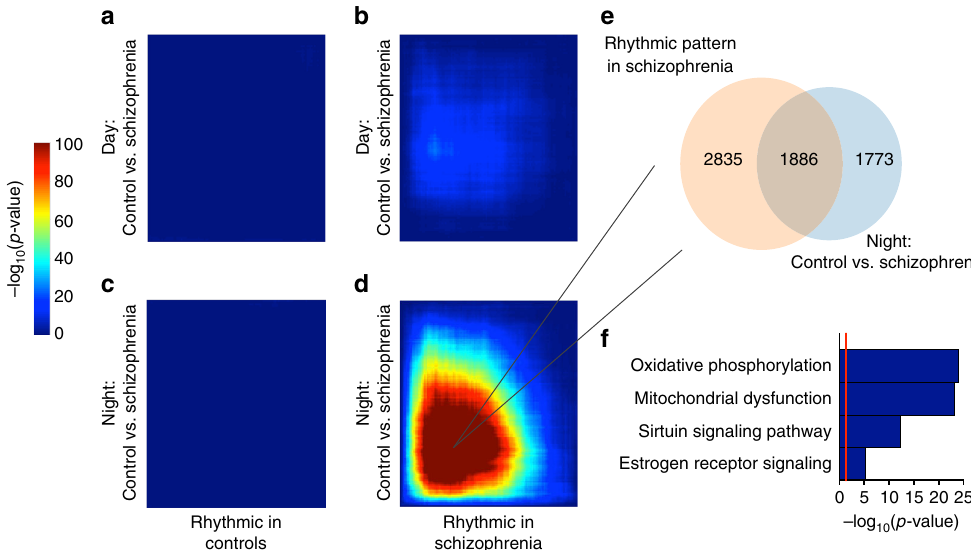
Fig. 6 Several genes that are rhythmic in schizophrenia are also DE in subjects that died at night. a – d RRHO plots indicating that there is a high level of overlap between genes that are changed in schizophrenia during the night and rhythmic in subjects with schizophrenia. Venn diagram ( e ) indicating overlap in genes that are DE at night and rhythmic in schizophrenia and top pathways ( f ) for these genes relate to oxidative phosphorylation